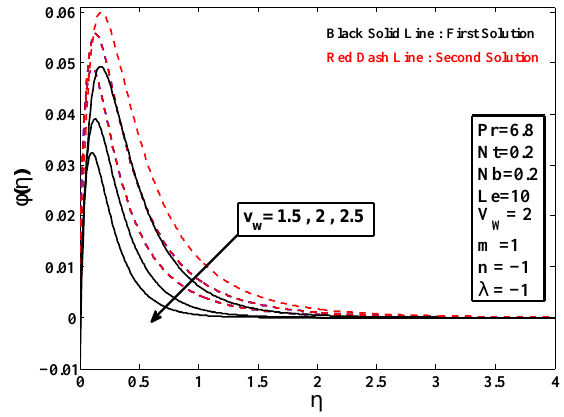
Figure 9: First and second solutions of velocity profile f (cid:48) ( η ) for dif- ferent values of transpiration rate parameter V w .